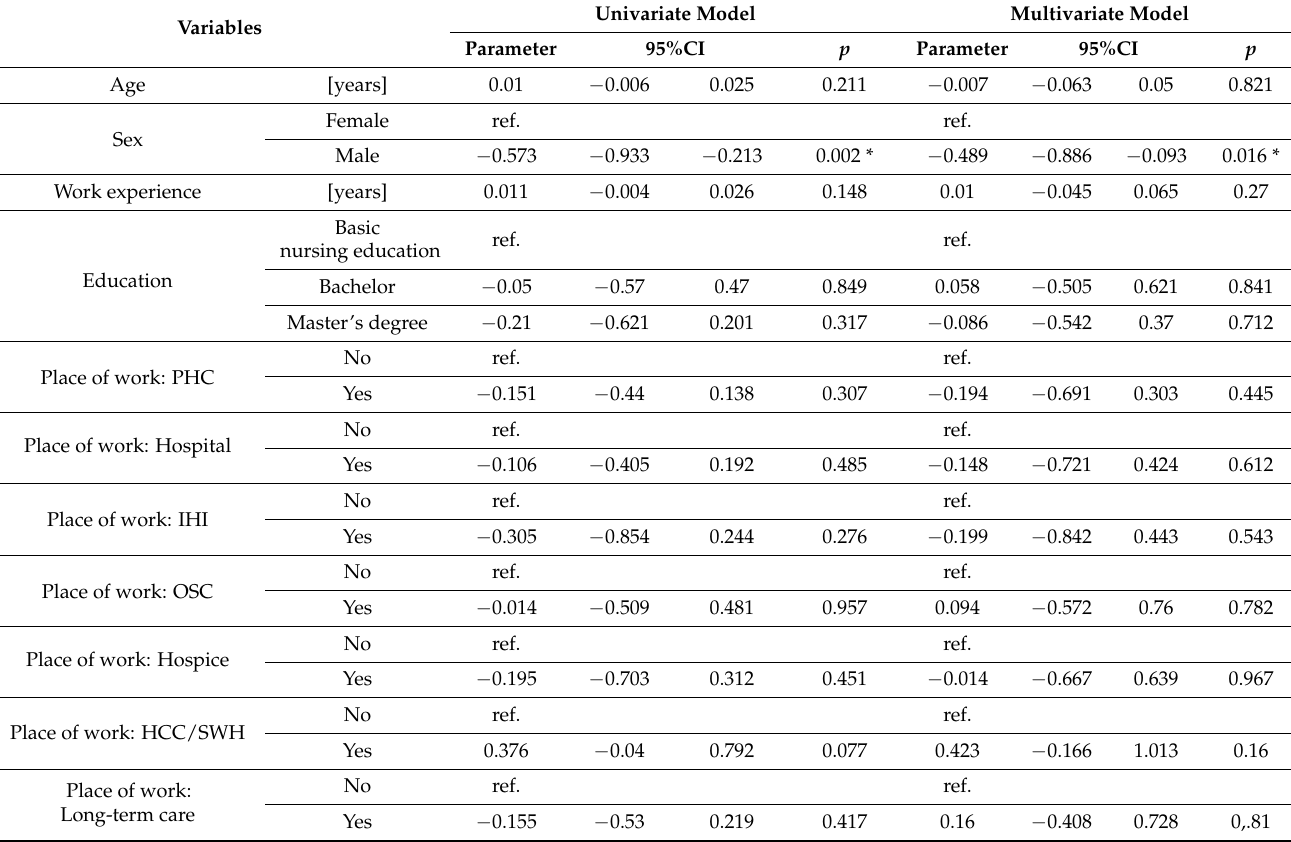
Table 7. Predictors of nurses’ sedentary behaviors (n =